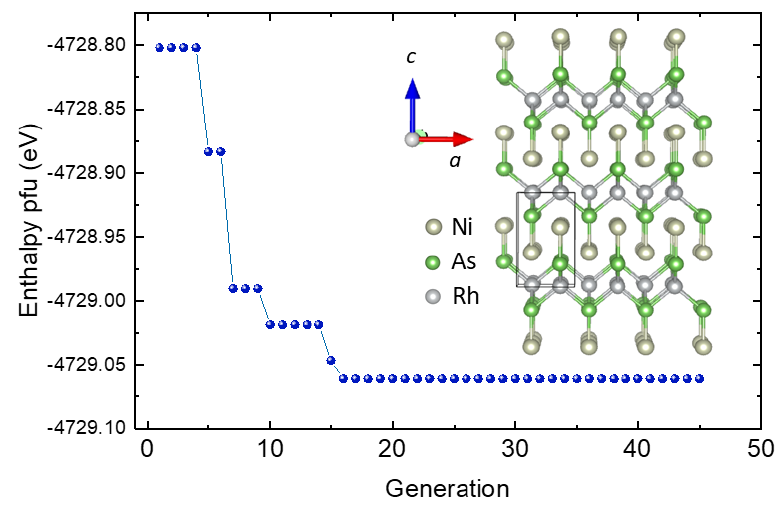
Figure 1. Enthalpy of the best individuals after each generation for a typical USPEX run. The inset shows the resulting (correct) structure, with double layers of Rh and As atoms.